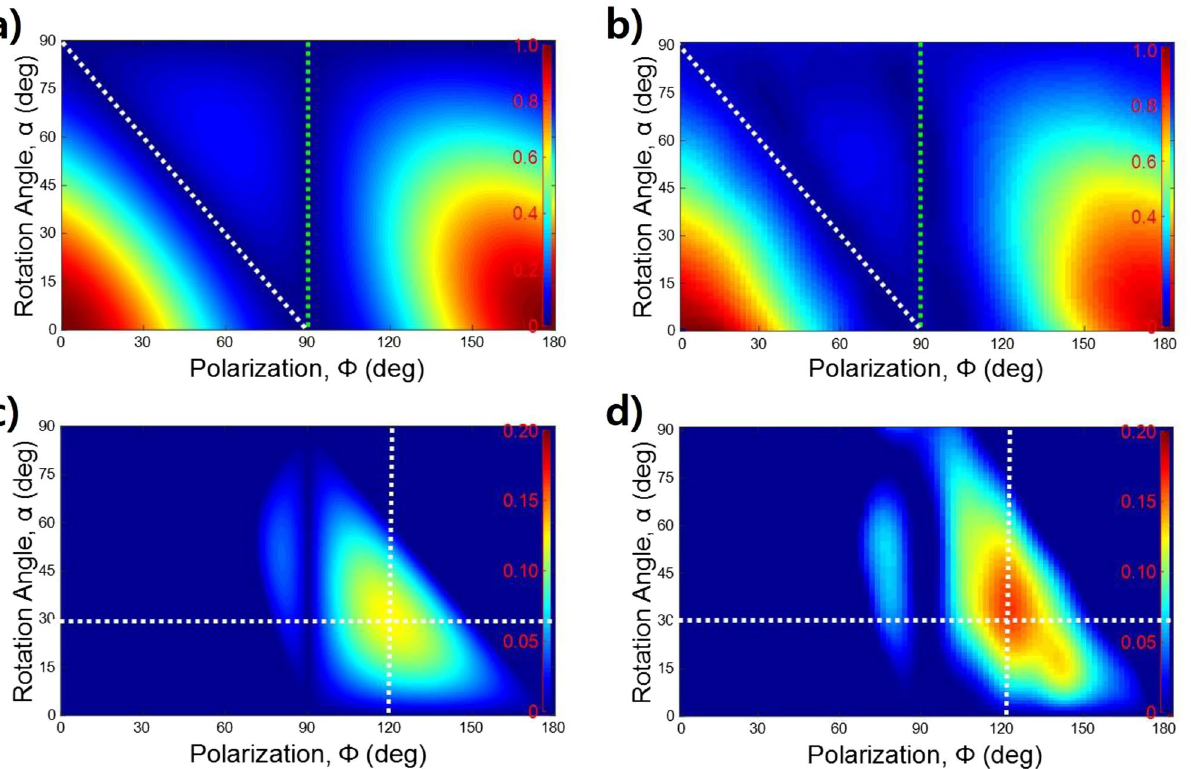
Figure 6. 2-D images of transmittance according to polarization angle and rotation angle: ( a ) calculation by Eq. (2); ( b ) measurement. The dashed green and white lines indicate the minimum transmittance when the polarization angle is 90° and when the sum of the polarization angle and the rotation angle is 90°, respectively. 2-D image of paradoxical area as shown in the yellow of Fig. 5a: ( c ) calculation; ( d ) measurement. The intersections of the dashed lines indicate the strongest